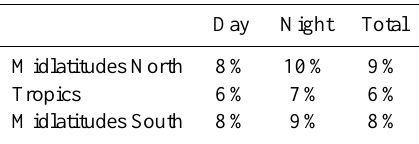
Table 3. Cirrus clouds cover obtained from the final database,